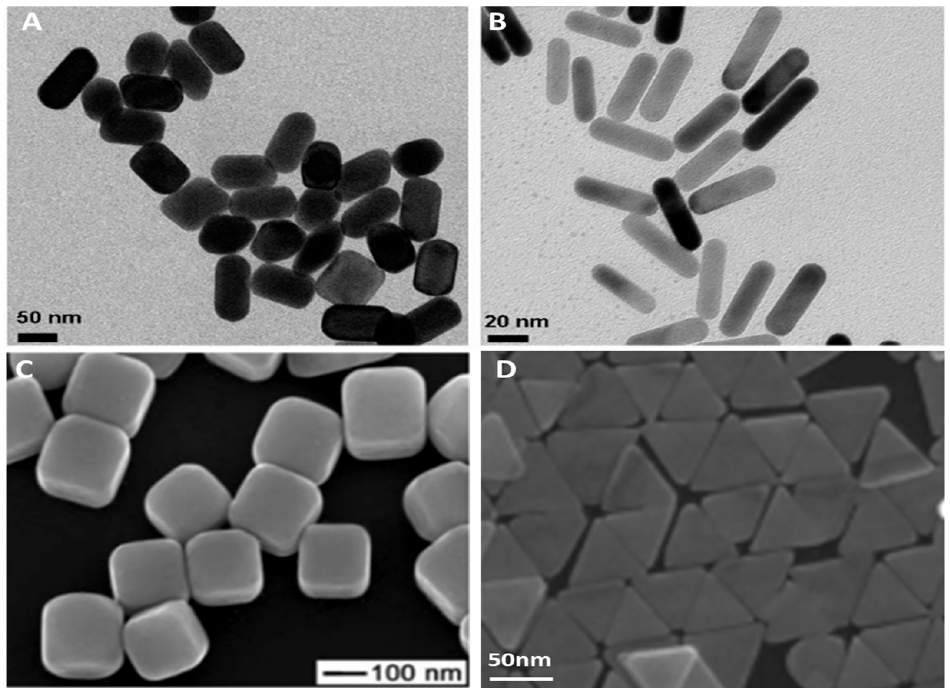
Figure 4. Images of different shapes of nanoparticles used in drug detection. ( A , B ) TEM images of gold nanorods. ( C ) SEM image of silver nanocubes. ( D ) SEM image of triangular nanoplates (Reproduced from Ref. [69] with permission from IOP.) (Reproduced from Ref. [70] with permission from RSC).